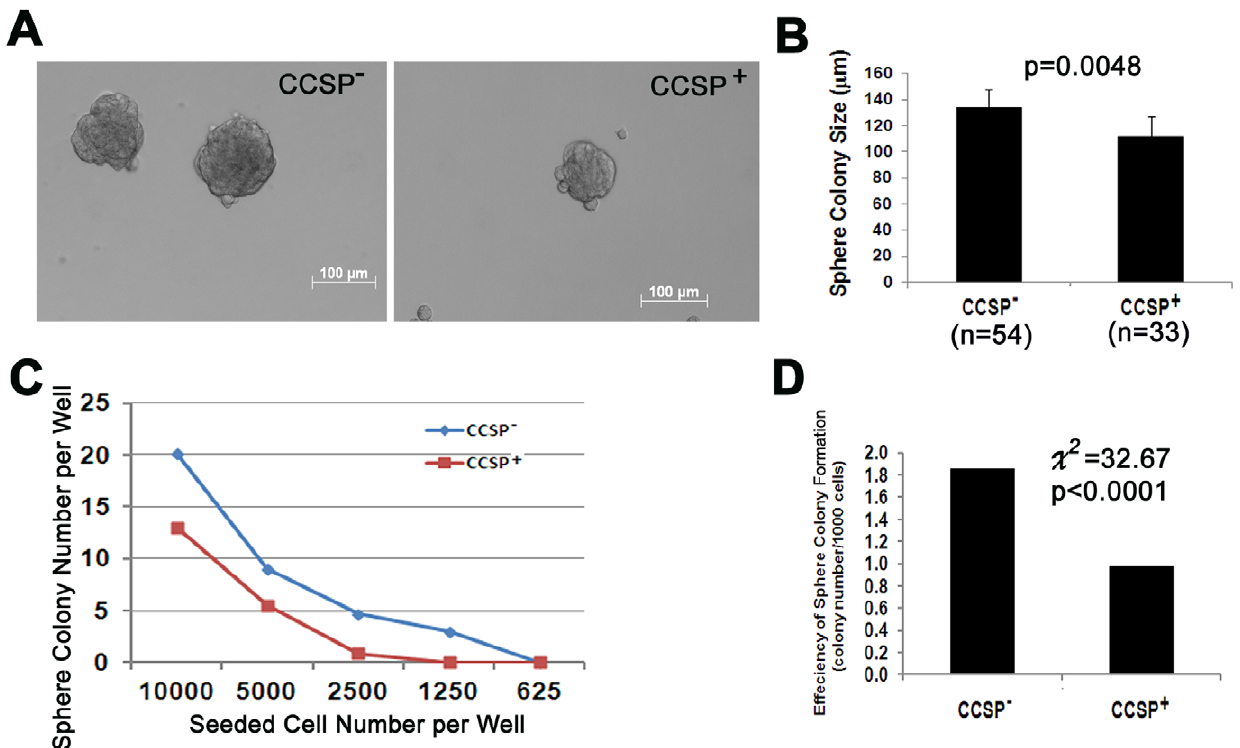
Figure 5. Bronchosphere formation by sorted cells. A) Phase-contrast photomicrographs of bronchospheres (Bar=100 m m). B) The diameter of all spheroid colonies in the wells which 5000 cells were seeded. Bar graph reveals average spheroid colony size ( m m). (Mean 6 S.D. p=0.0048, Student t-test). C) Average spheroid colony number per well in serial diluted cells after one week sphere cell culture. D) Efficiency of sphere colony formation=total colony number/total seeded cell 6 1000. Efficiency of sphere colony formation was higher in CCSP 2 cells than that in CCSP + cells (p , 0.0001, Chi-square test).